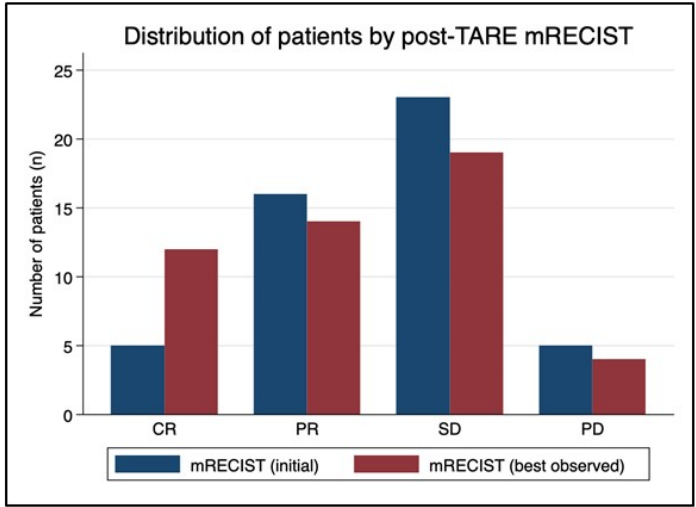
Figure 3. mRECIST migration over time. The mean time from TARE to initial mRECIST assessment was 87 days (range 40–136 days). After the initial post-TARE assessment, mRECIST scores improved in subsequent studies for 12 patients. In that group, five patients characterized with stable disease (SD) at 3-month follow-up subsequently developed a complete response (CR), three patients with initial partial response (PR) were later classified with CR, two patients with initial SD went on to develop PR, and two patients with progressive disease (PD) were downstaged to SD. Mean time from TARE to best mRECIST score was 188 days (range 40–799 days). Ultimately, mRECIST objective response was achieved after 27 of the 51 procedures (53%), with 23.5% of patients demonstrating CR and 29.4% demonstrating PR.